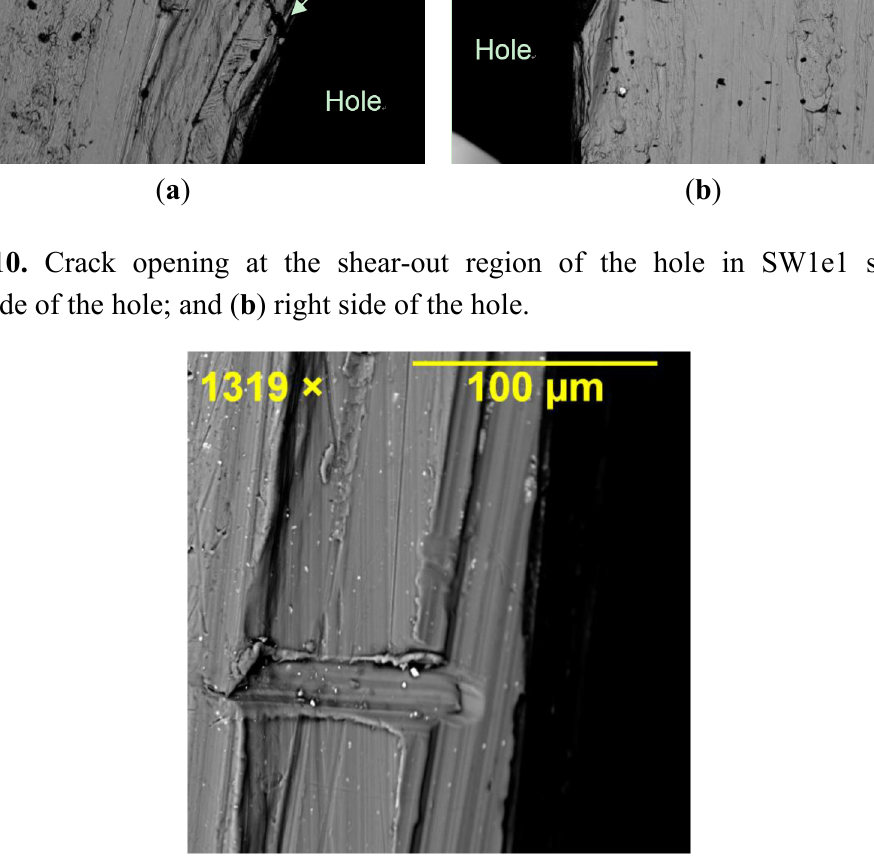
Figure 11. Shearing edge formed on the material surface of the cracked region in the middle plate of SW1e1